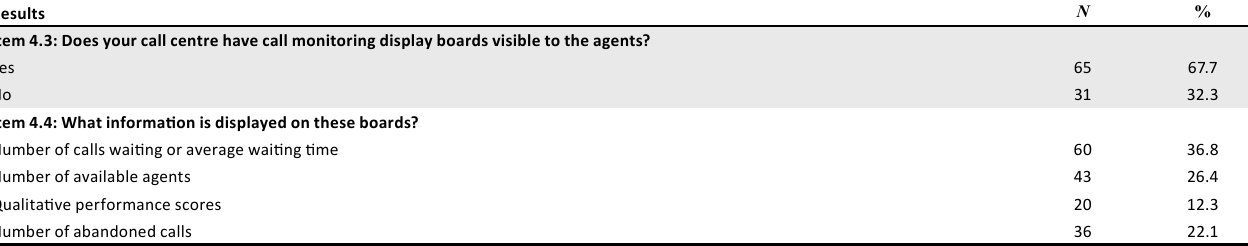
TABLE 5: Monitoring boards.